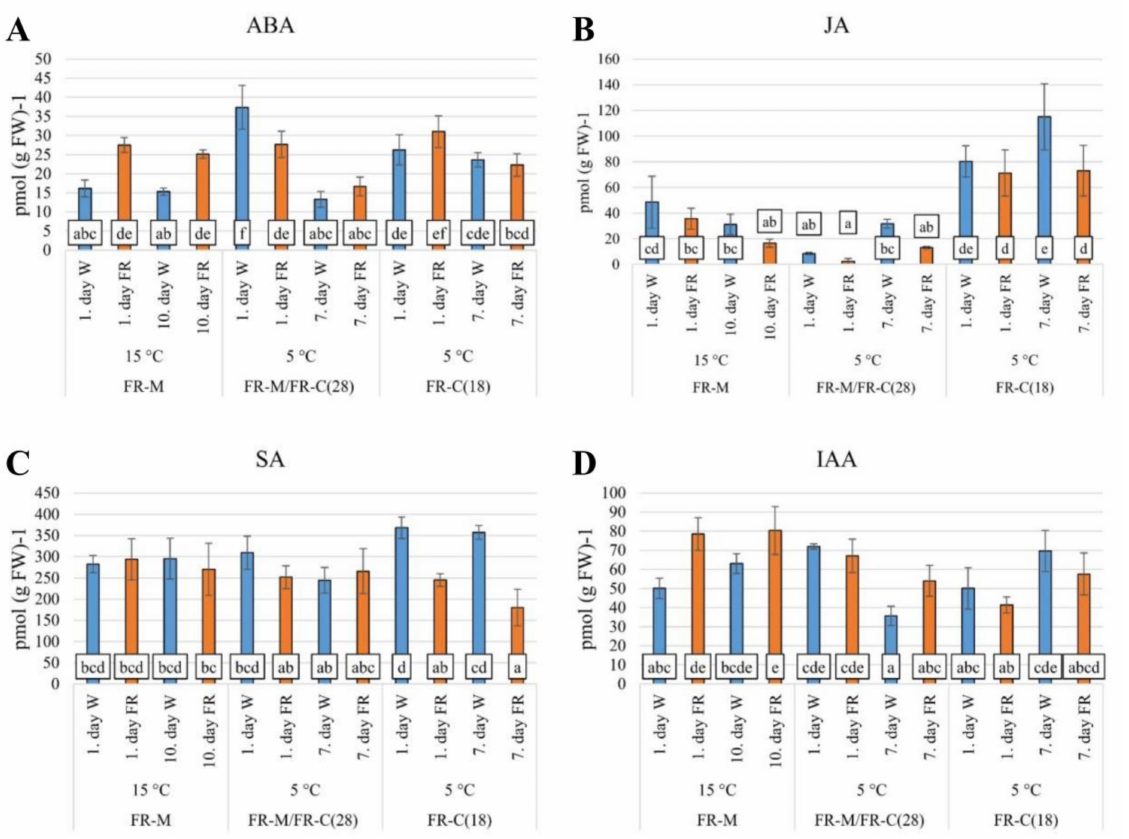
Figure 3. The impact of FR enrichment and moderate or low temperature on hormone concentrations. ( A ): ABA, abscisic acid; ( B ): JA, jasmonic acid; ( C ): SA, salicylic acid; ( D ): IAA, indole-3-acetic acid. Leaf samples were collected six to eight hours after the start of illumination. Plantlets were grown under 12 h photoperiod. FR-M: FR treatment at 15 ◦ C for 10 days. FR-M/FR-C(28): FR treatment at 15 ◦ C for 10 days + FR treatment at 5 ◦ C for 7 days. FR-C(18): FR treatment at 5 ◦ C for 7 days. Plant age at the start of the cold treatment was 28 days in the case of FR-M/FR-C(28) and 18 days in FR-C(18) variant. W: white light, FR: far-red-enriched white light. Mean and standard deviation values were calculated from three biological replicates. Significant differences between the columns were determined by Tukey’s-b test ( p <